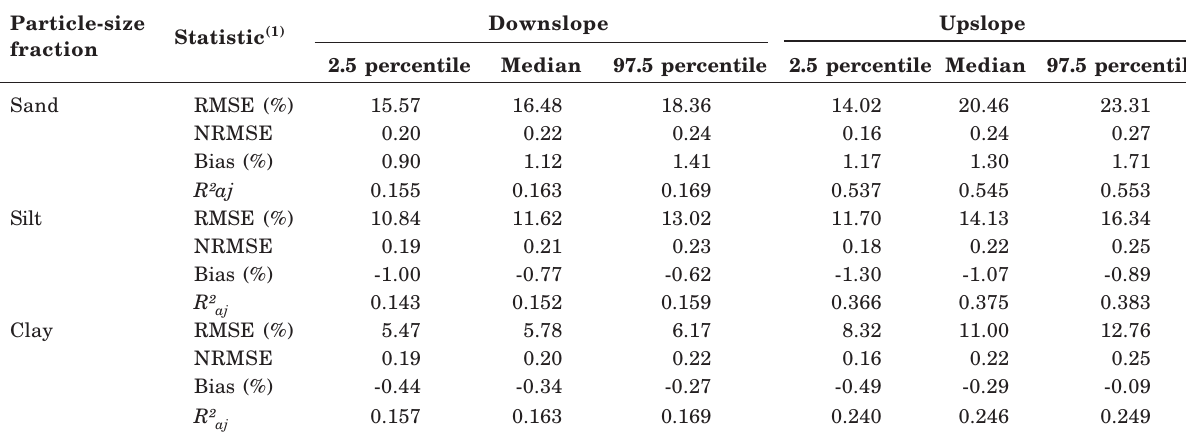
Table 4. Cross-validation statistics (10-fold; 100 repetitions) for prediction of psd in downslope and upslope positions based on application of predictive models